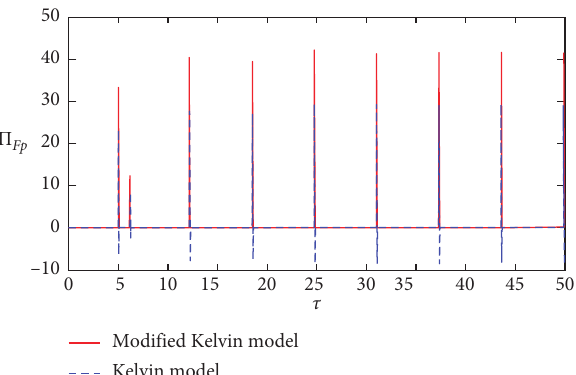
Figure 6: The pounding force histories of two inelastic SDOF structures under parameter set 1 using improved Kelvin model and Kelvin